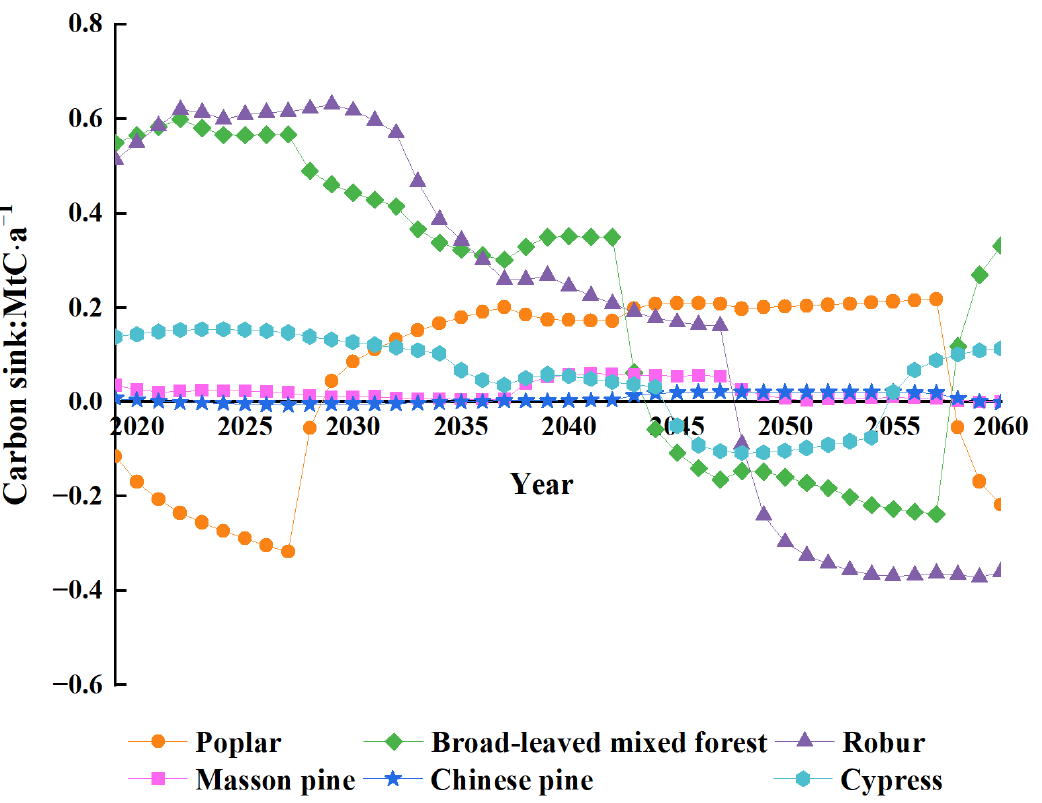
Figure 4. Carbon sinks in commercial forests of dominant tree species in Henan Province, 2019– 2060.